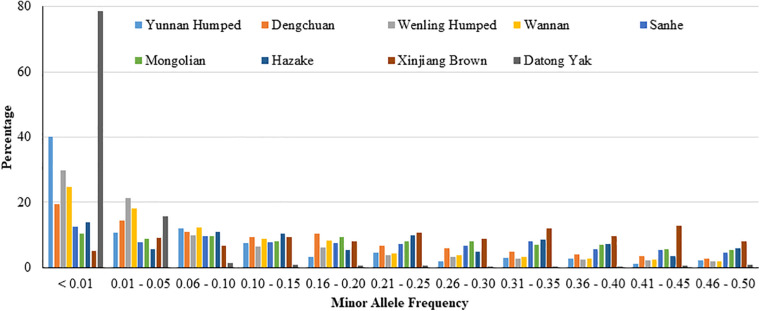
Distribution of single nucleotide polymorphisms (SNP percentage) by minor allele frequency ranges in eight Chinese cattle breeds and Datong yak.